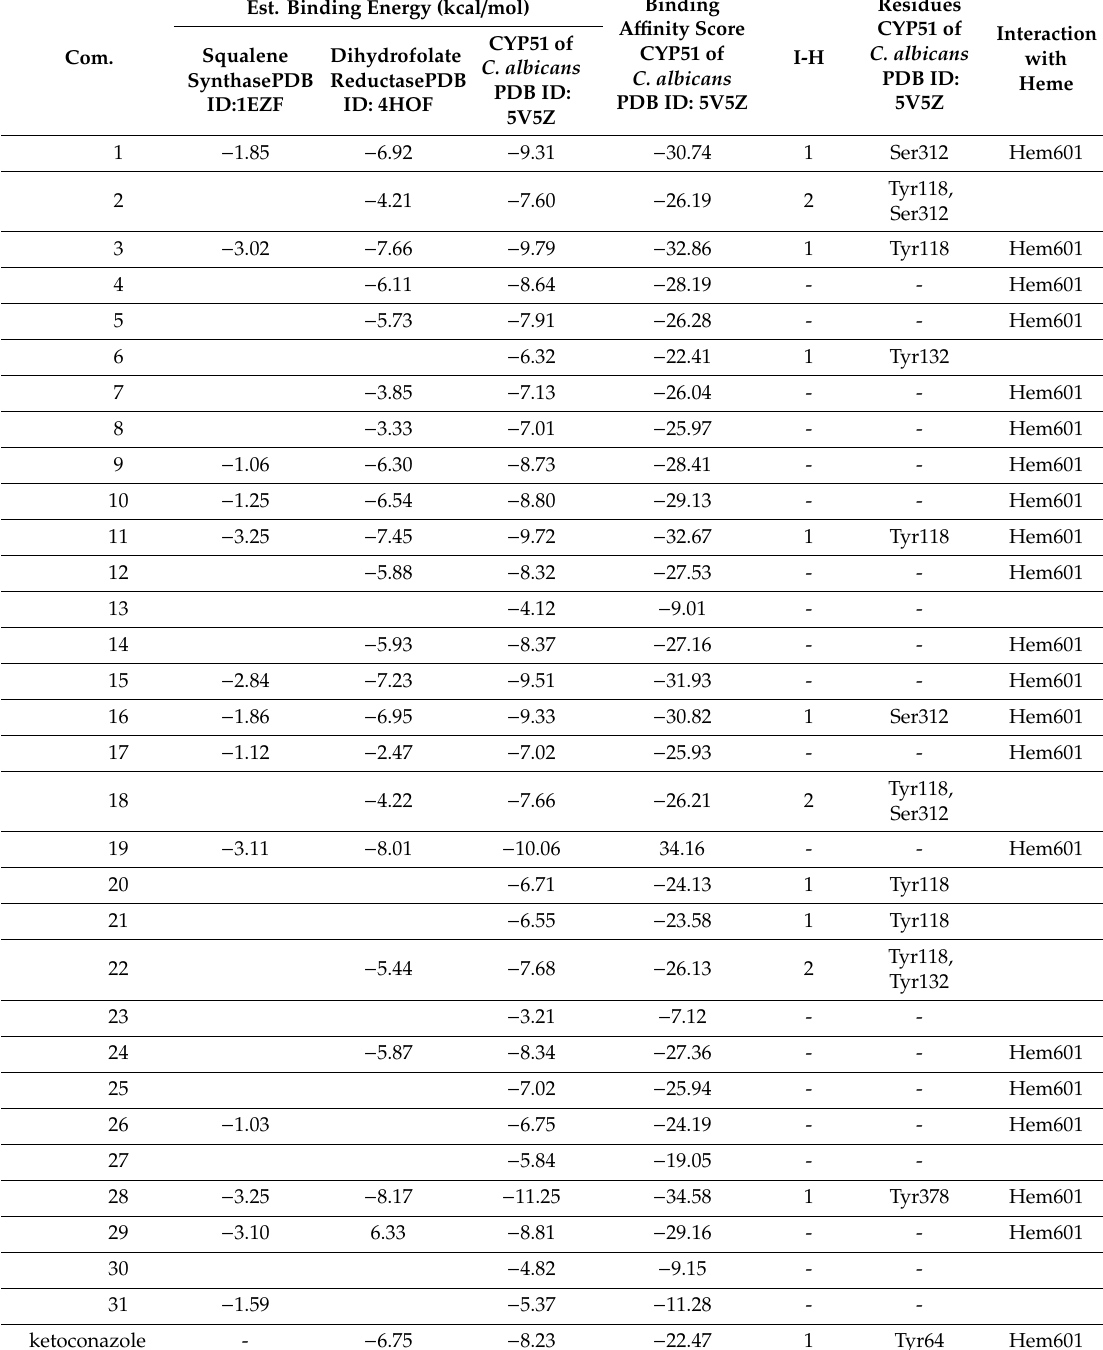
Table 6. Molecular docking binding a ffi